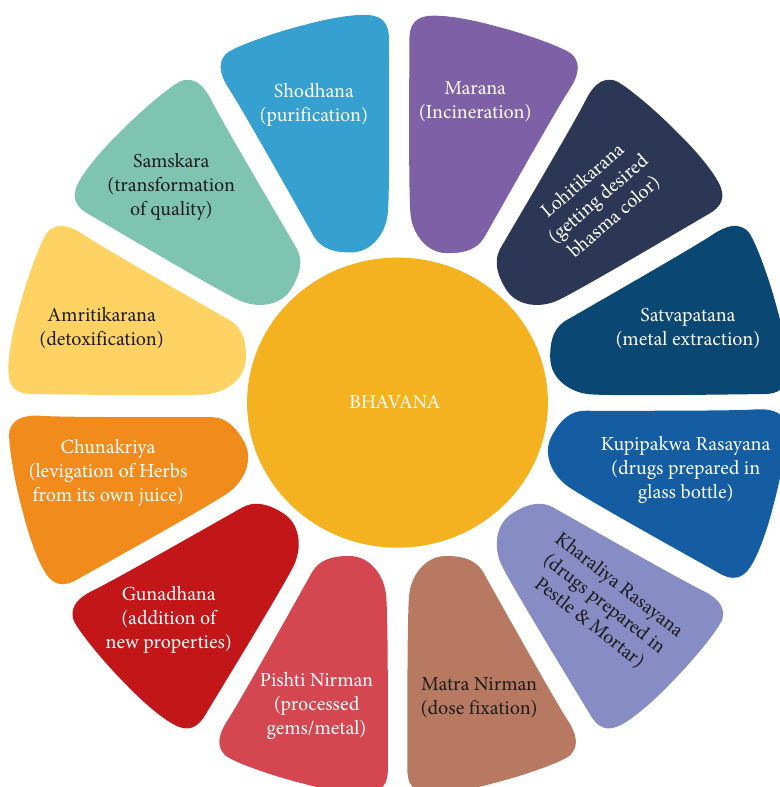
Figure 1: Pharmaceutical implications of Bhavana in Ayurvedic